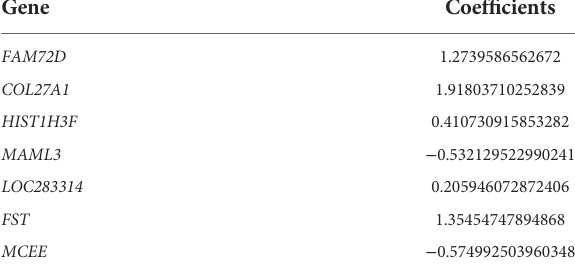
TABLE 1 Corresponding penalty coef fi cients of seven retained